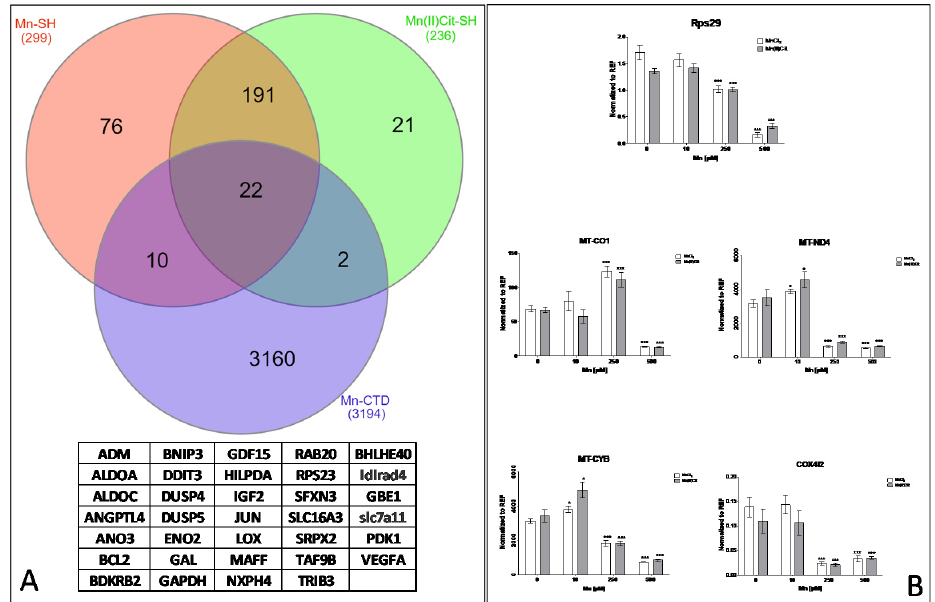
Figure 4. ( A ) The enriched set of proteins identified using PPI data, including genes identified by transcriptomics analysis and added by String were analyzed using the comparative toxicogenomic data. A set of 34 curated genes were identified that previously were affected by MnCl 2 or other Mn compounds. ( B ) Representative genes associated with protein synthesis, cell metabolism, and neurodegeneration were analyzed by qRT-PCR analysis (mean ± sem, n = 3). Statistical differences were verified by two-way ANOVA, followed by Bonferroni post test, (*, p < 0.05; ***, p < 0.001). Lastly, our findings suggest that chemical species of Mn induce cytotoxicity in the RA-differentiated SH-SY5Y -DAergic cell model (Figures 1 and 5A) through alterations of the expression in a notable number of genes (Tables S1 and S2 and Figure 5B), because of which numerous pathways are harmed (Figures 3 and 5C). There, disruption of protein perturbation (Figure 5C) responsible for Mn-induced neurotoxicity, which may result